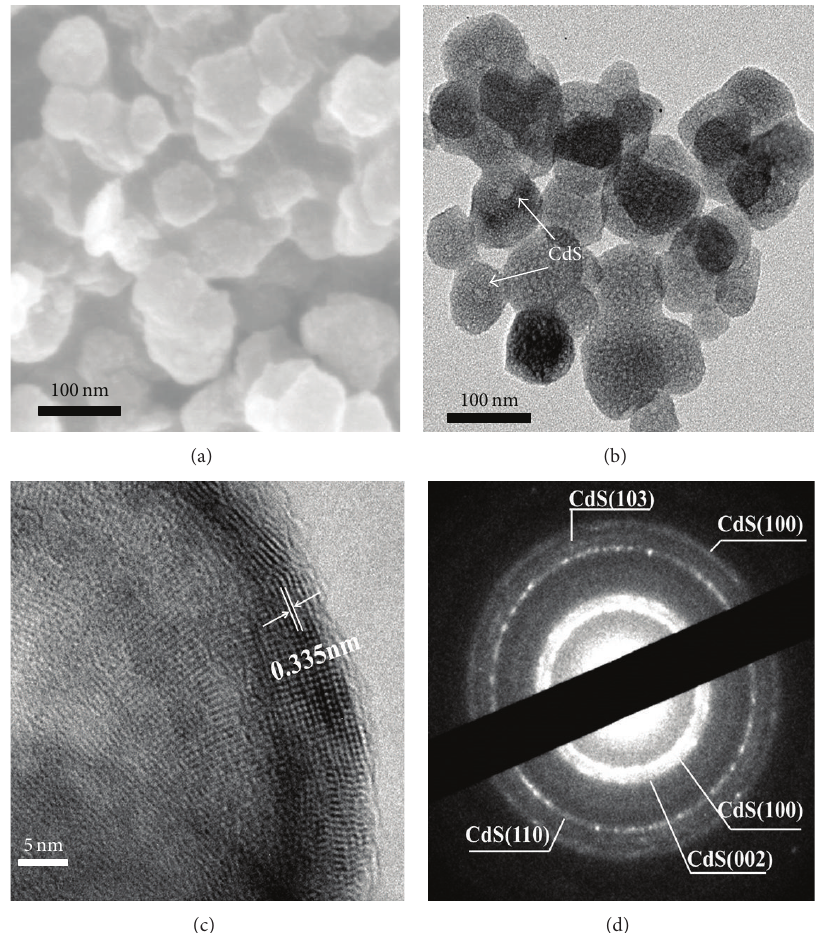
Figure 1: (a) SEM image of CdS/CN-10; (b) TEM image of CdS/CN-10; (c) HRTEM image of CdS/CN-10; (d) SAED pattern of